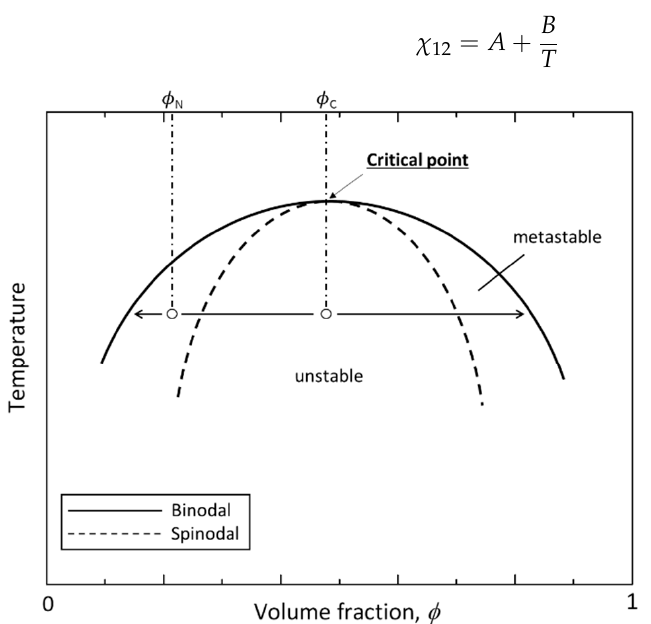
Figure 1. Illustrative phase diagram of a binary system showing UCST behavior. φ c is the volume fraction of the critical composition, where spinodal decomposition occurs at temperature T 1 . φ N is the volume fraction of composition, where nucleation-growth occurs at temperature T 1 .